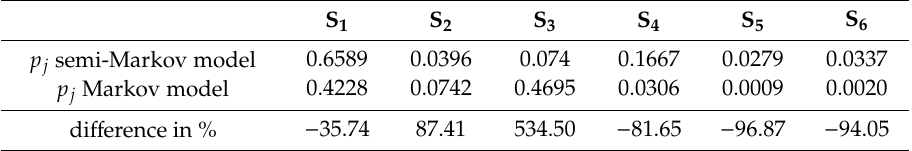
Table 11. Comparison of results for the Markov and semi-Markov